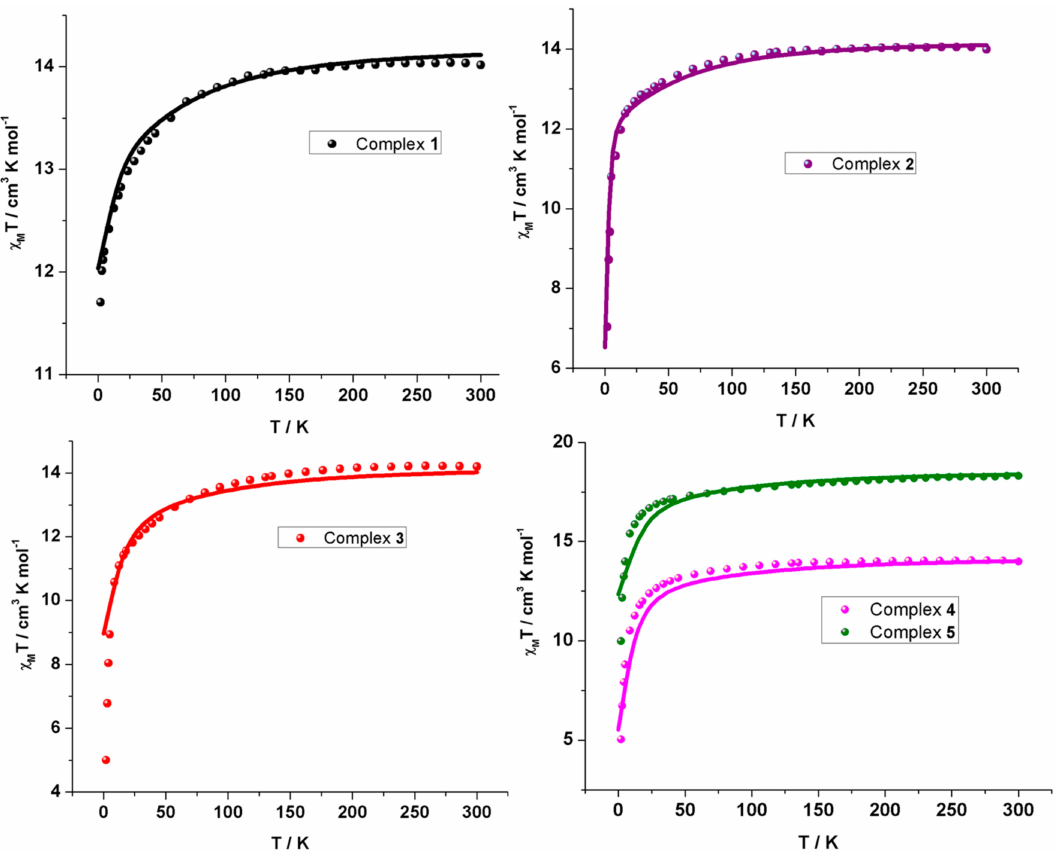
Figure 3. χ M T vs. T for 1 – 5 with an applied magnetic field of 1 T. The solid color lines are calculated χ M T values by ab initio calculations (See theoretical studies and Table S8 in the